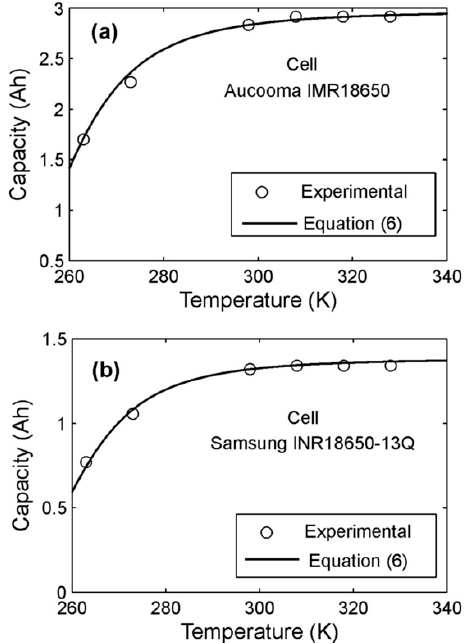
Figure 1. Dependence of cell released capacity on temperature of studied cells at discharge current 0.2 C n (C n is cell nominal capacity): ( a ) cell with cathode LiMn 2 O 4 (IMR); and ( b ) cell with cathode LiNiMnCoO 2 (INR).